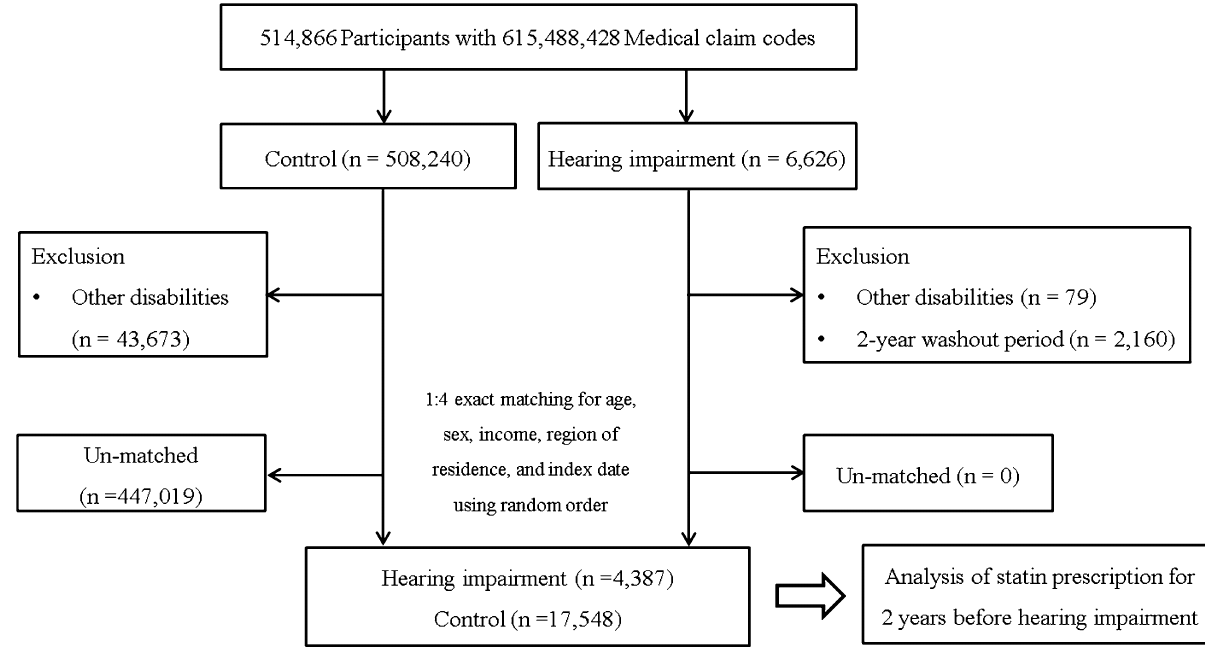
Figure 1. A schematic illustration of the participant selection process that was used in the present study. Of a total of 514,866 participants, 4,387 participants with hearing impairment were matched with 17,548 control participants for age, sex, income, and region of